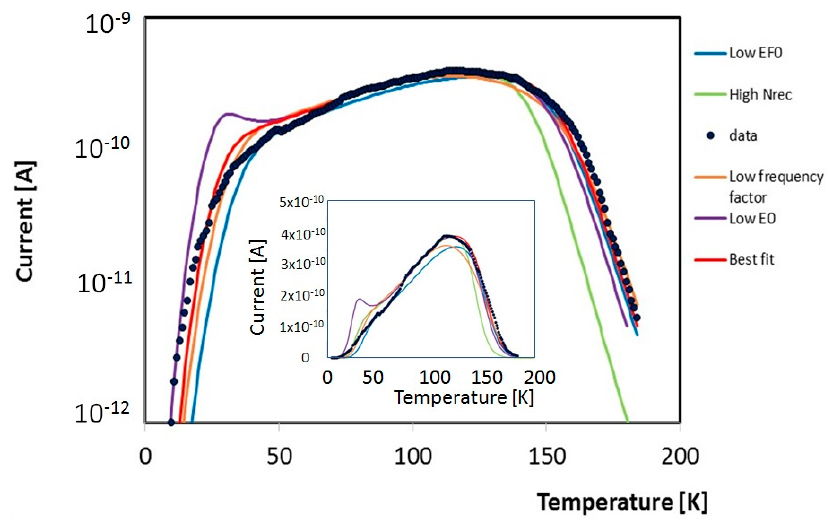
Figure 6. Fit procedure of data measured during a unique TSC emission in the range 5–200 K (convoluted from data of Figure 3). Red: best fit obtained with N rec = 75 × 10 20 m − 3 , frequency factor ν 0 = 4 × 10 12 s − 1 , E F0 = 66.5 meV, E L = 60 meV, N L = 10 20 m − 3 . Green: same with higher concentration of recombination centres N rec = 6 × 10 22 m − 3 , violet: same with lower E L = 50 meV, orange: same with lower frequency factor ν 0 = 2 × 10 12 s − 1 , blue same with lower initial Fermi level E F0 = 72.2 meV.